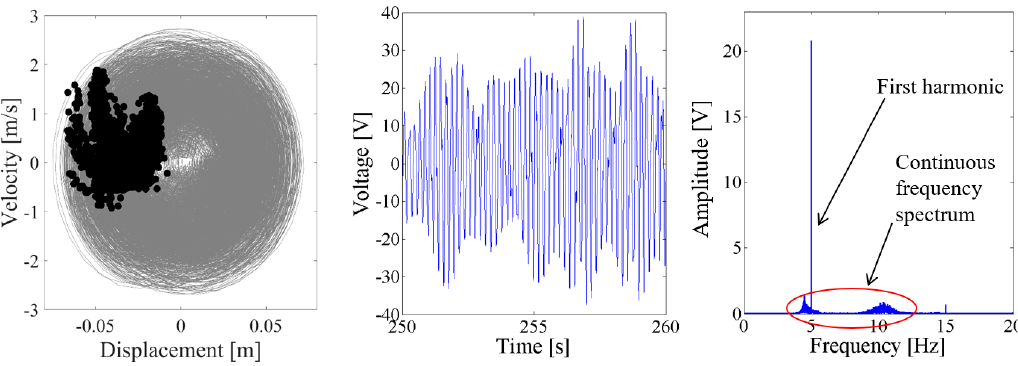
Figure 21. Dynamic responses of the coupled harvester-2 for the excitation level of 1.5 g.